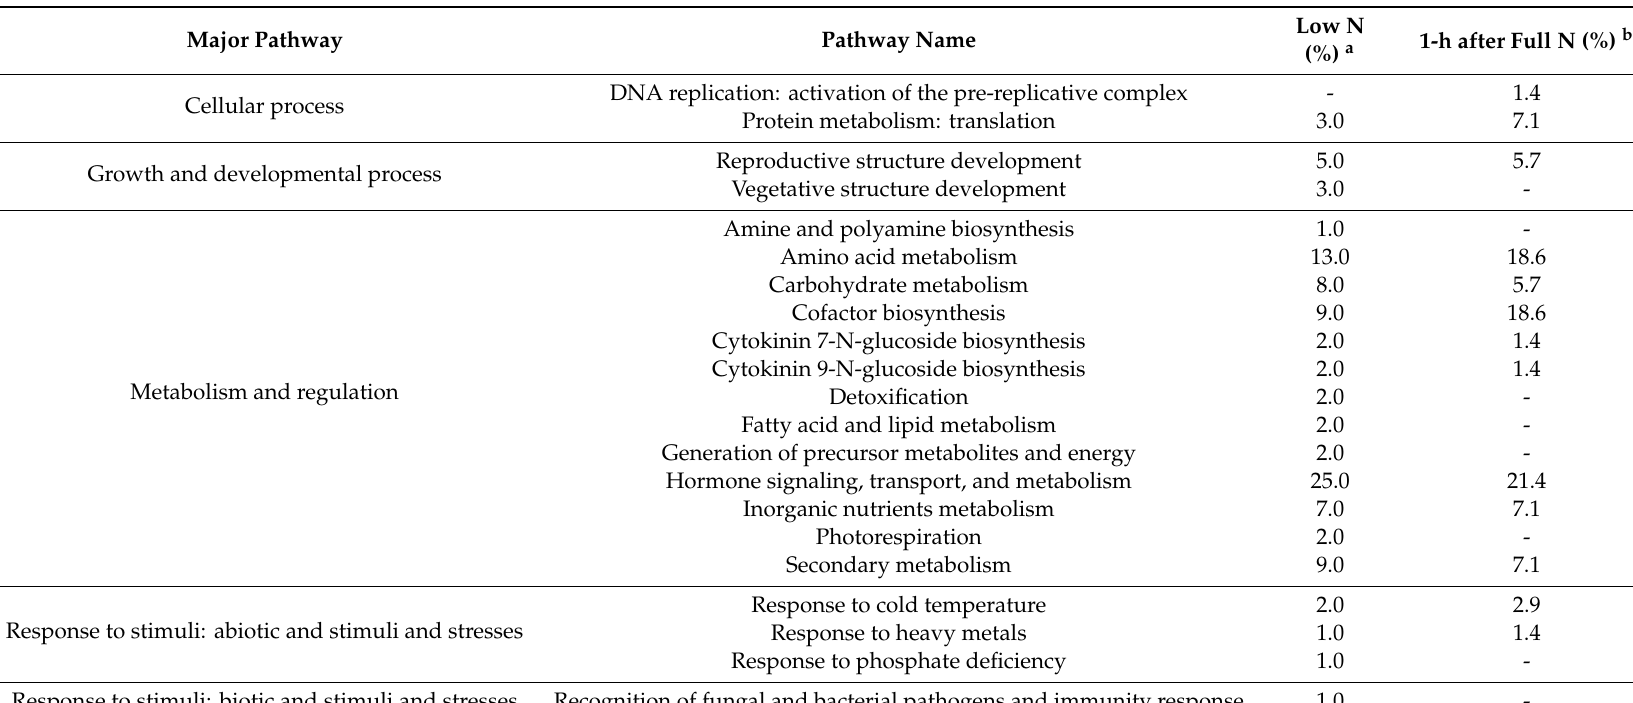
Table 2. Distribution of di ff erentially expressed genes (%) in Plant Reactome pathway